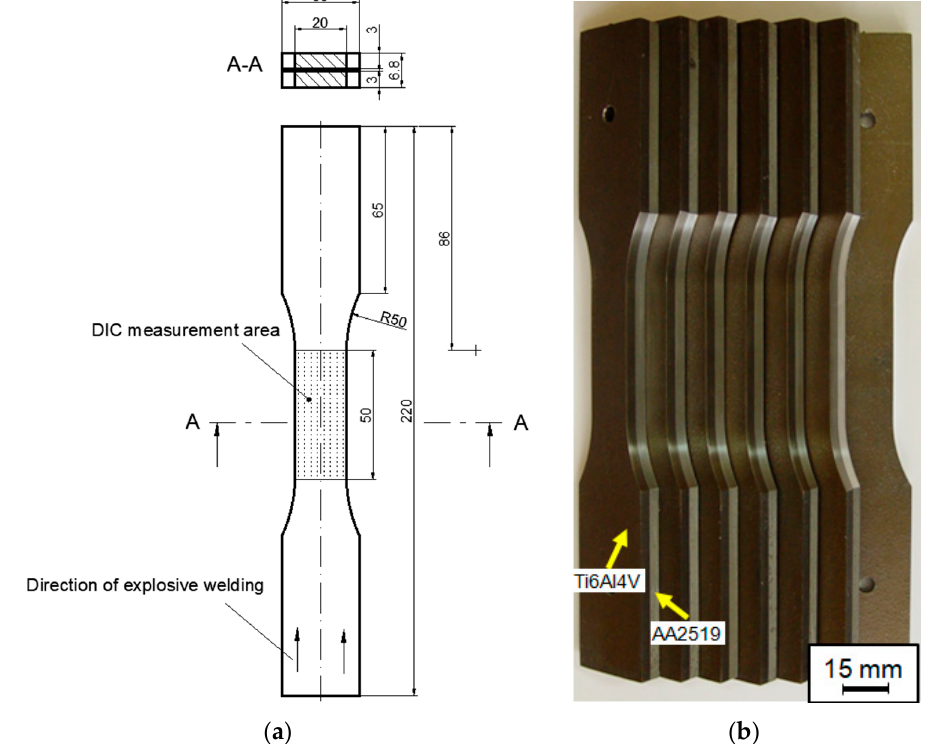
Figure 3. Dimensions of samples for tensile testing of AA2519-Ti6Al4V laminate with inter-layer of AA1050 ( a ) and prepared test specimens ( b ).